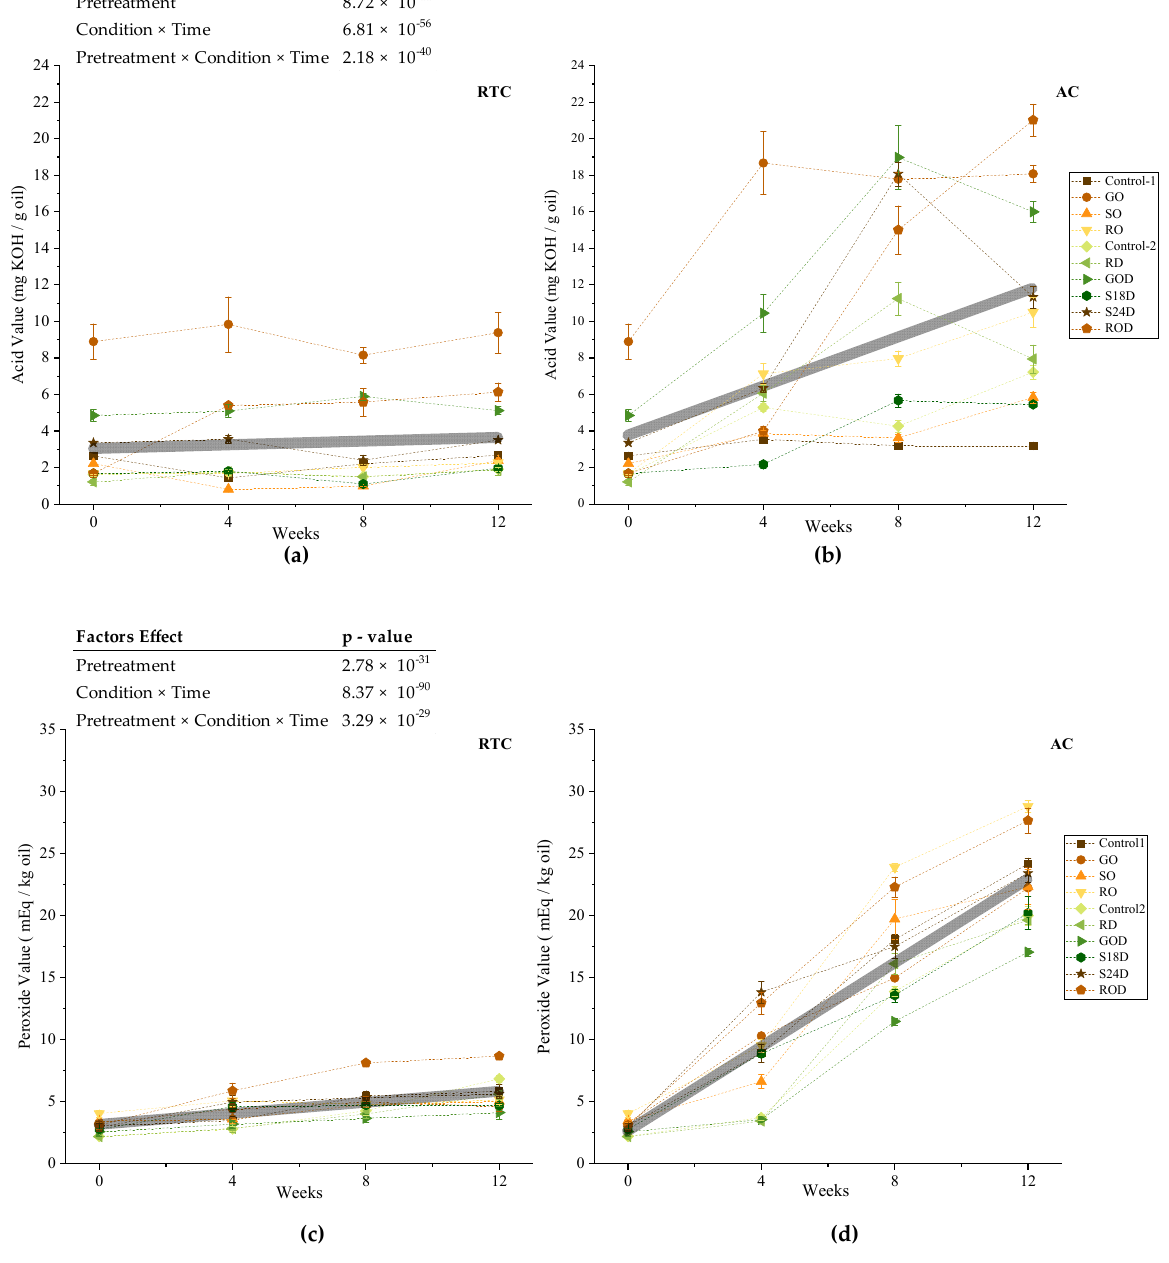
Figure 3. Changes in oxidative stability markers of FFSF kept under RTC and AC during 12-week storage. Thick gray lines represent overall pretreatment trend effect within each condition. ( a ) Change in AV under RTC; ( b ) change in AV under AC; ( c ) change in PV under RTC; ( d ) change in PV under AC. (Control-1 FFSF = control sample of non-dehulled batch; germinated only FFSF = GO; soaked only FFSF = SO; roasted only = RO; Control-2 FFSF = control samples of dehulled batch; raw dehulled FFSF = RD; germinated and dehulled FFSF = GOD; soaked 18 h and dehulled FFSF = S18D; soaked 24 h and dehulled = S24 h; roasted and dehulled = ROD).